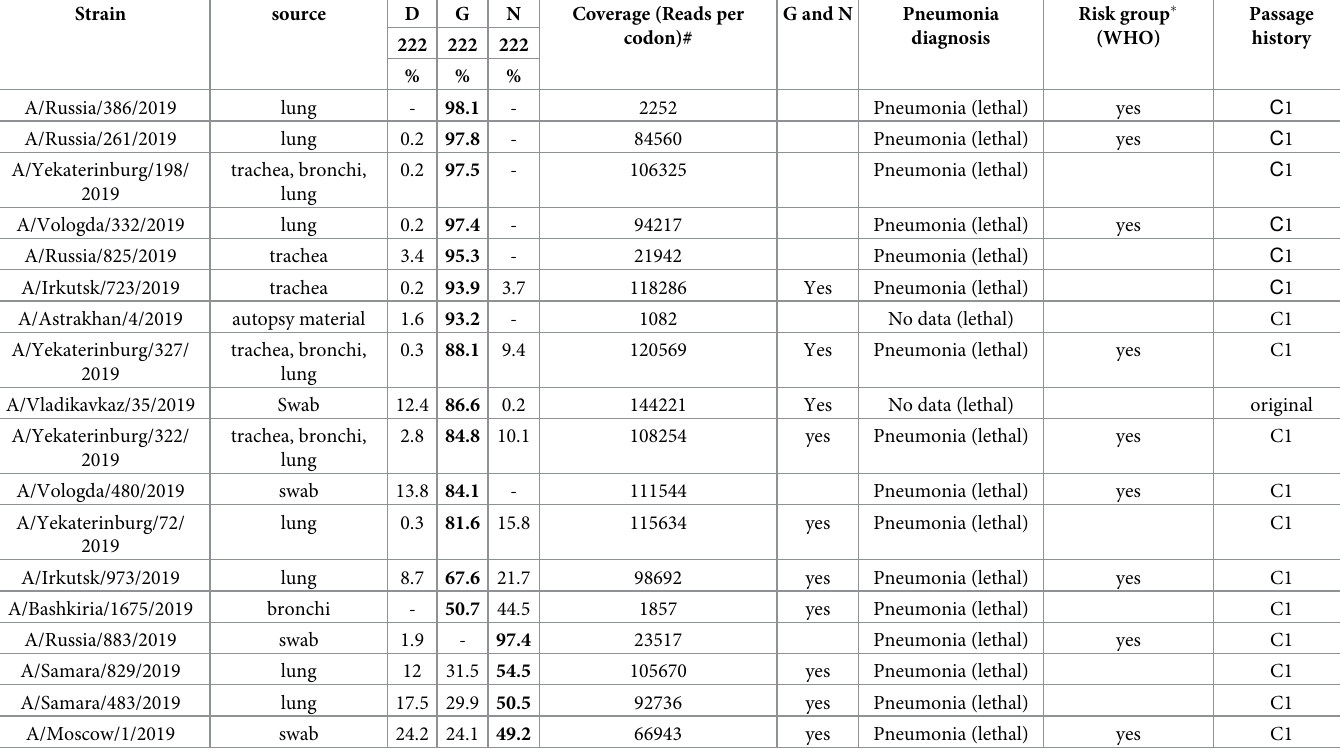
The table shows the percentage of virus variants with the mutations in the